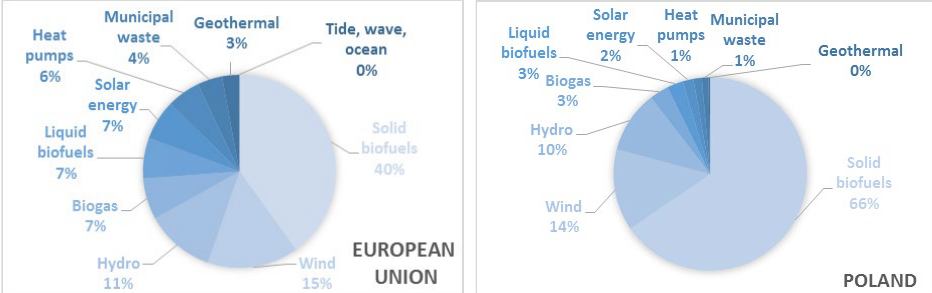
Figure 4. Structure of primary electricity energy production from RES in 2019 in the EU and Poland.